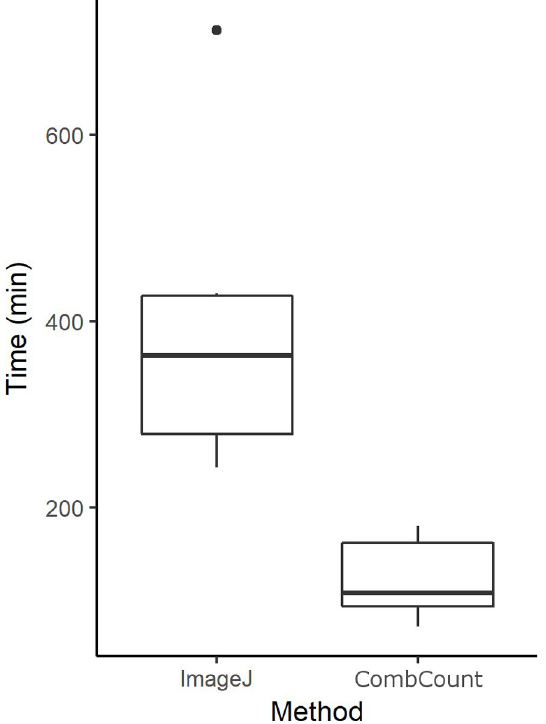
Fig 2. Time taken by the observers to measure 30 frames (minutes). Lower and upper edges of the boxes represent the 1 st and 3 rd quartiles respectively, the thick black lines in the boxes represent medians, whiskers extend from minimum to maximum values, one value greater than the 3 rd quartile by more than 1.5 times is shown as a dot.